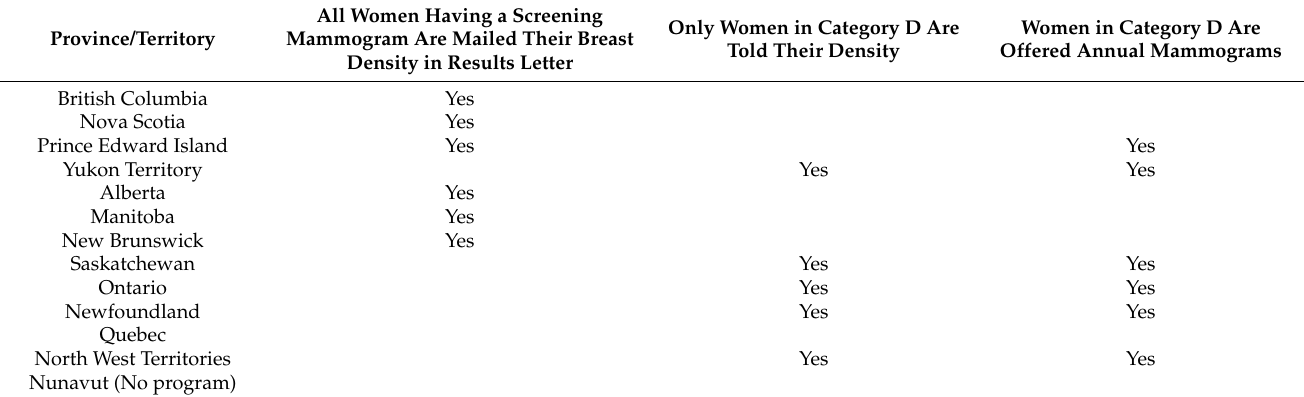
Table 4. Breast density notification differences between jurisdictions in Canada